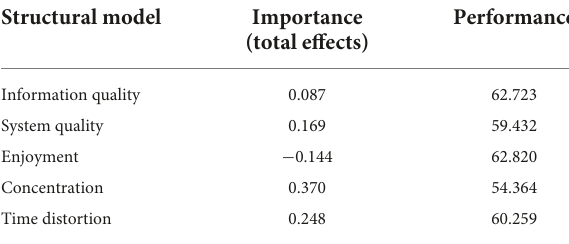
Table 8 and Figure 2 present the results of IPMA which